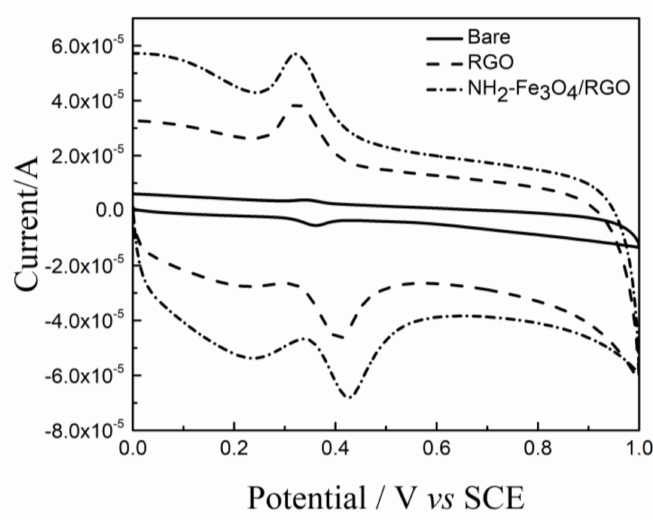
Figure 5. CVs of 1 × 10 − 5 mol/L DA on bare GCE, RGO/GCE and NH 2 –Fe 3 O 4 /RGO/GCE recorded